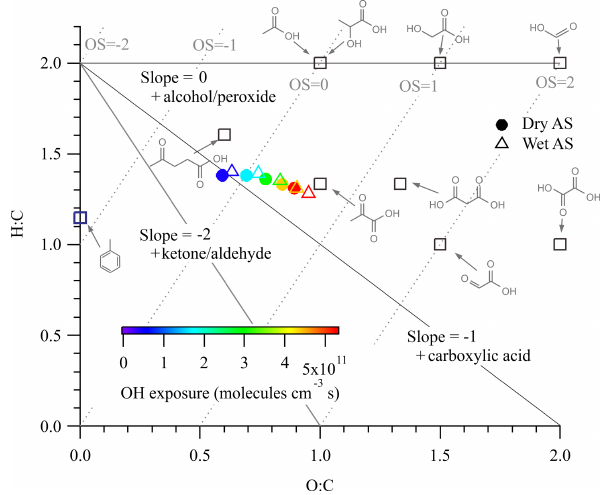
Figure 6. Van Krevelen diagram of SOA derived from the photoox- idation of toluene on initially wet and dry AS seed particles. SOA data are colored according to the OH exposure. Products identi- fied in toluene-derived SOA are shown in boxes (Bloss et al., 2005; Hamilton et al., 2005; Sato et al., 2007). Average carbon oxidation states from Kroll et al. (2011) and functionalization slopes from Heald et al. (2010) are shown for